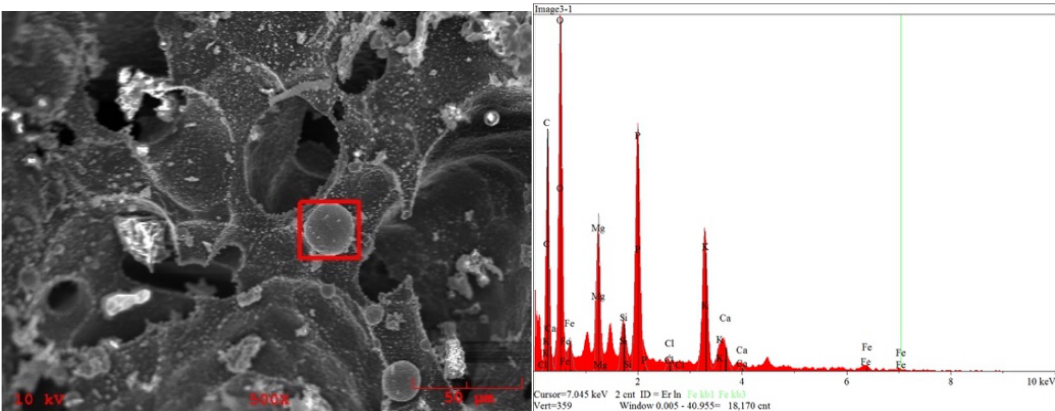
Figure 8. Surface area analysis from outer soybean biochar (Elements from left to right Cl, K, Ca, C, O, Mg, Si. P, Cl, K, Ca,